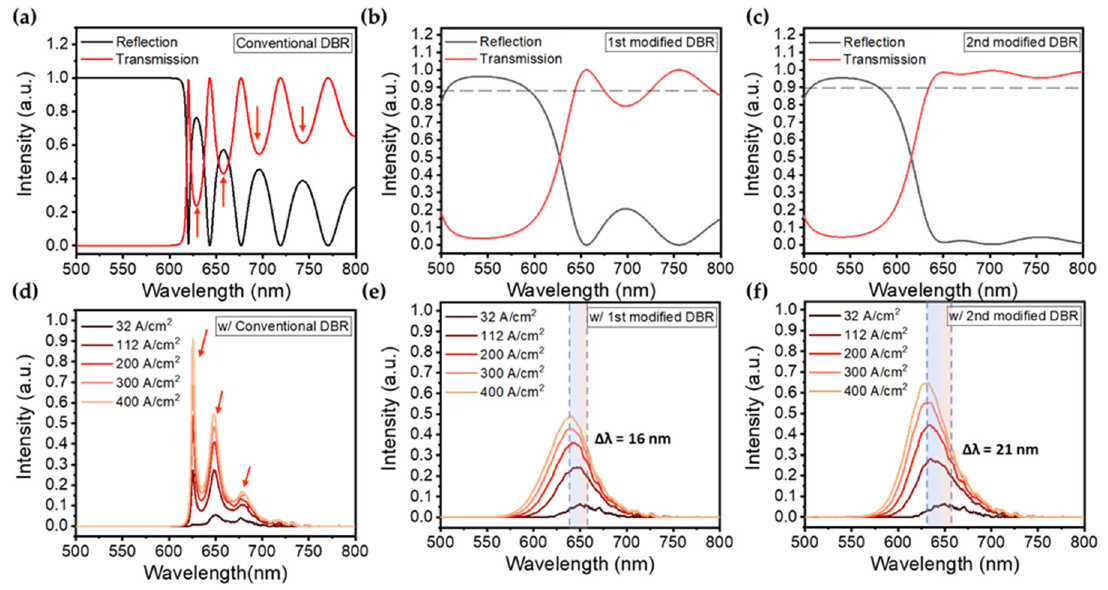
Figure 4. Calculated transmittance and reflectance spectra of ( a ) conventional DBR structure, ( b ) the 1st modified DBR structure, and ( c ) the 2nd modified DBR structure, the dotted line represents the transmittance of 90%. The electroluminescence spectra of the InGaN red micro-LEDs ( d ) with conventional DBR, ( e ) with the 1st modified DBR and ( f ) with the 2nd modified DBR. Red arrows indicate the center of ripples and multi-peaks, and the colored region shows the range of blue shift.